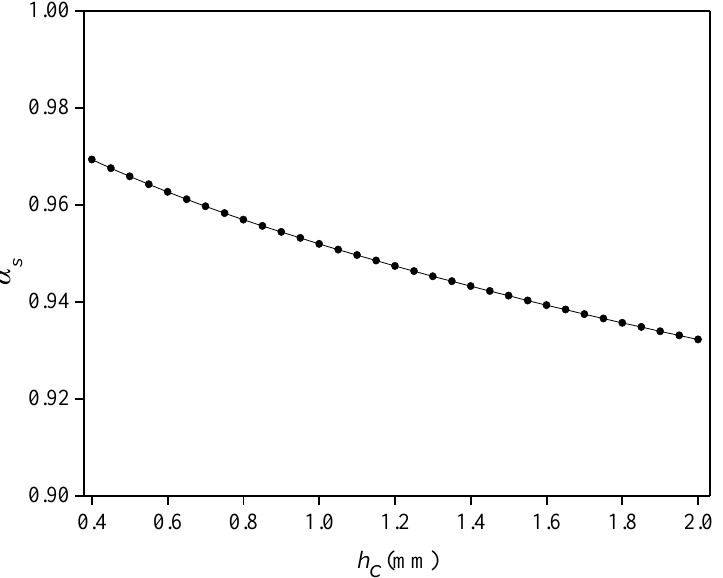
Figure 6. Relationship between thickness of cemented layer and average strain-transfer coefficient.